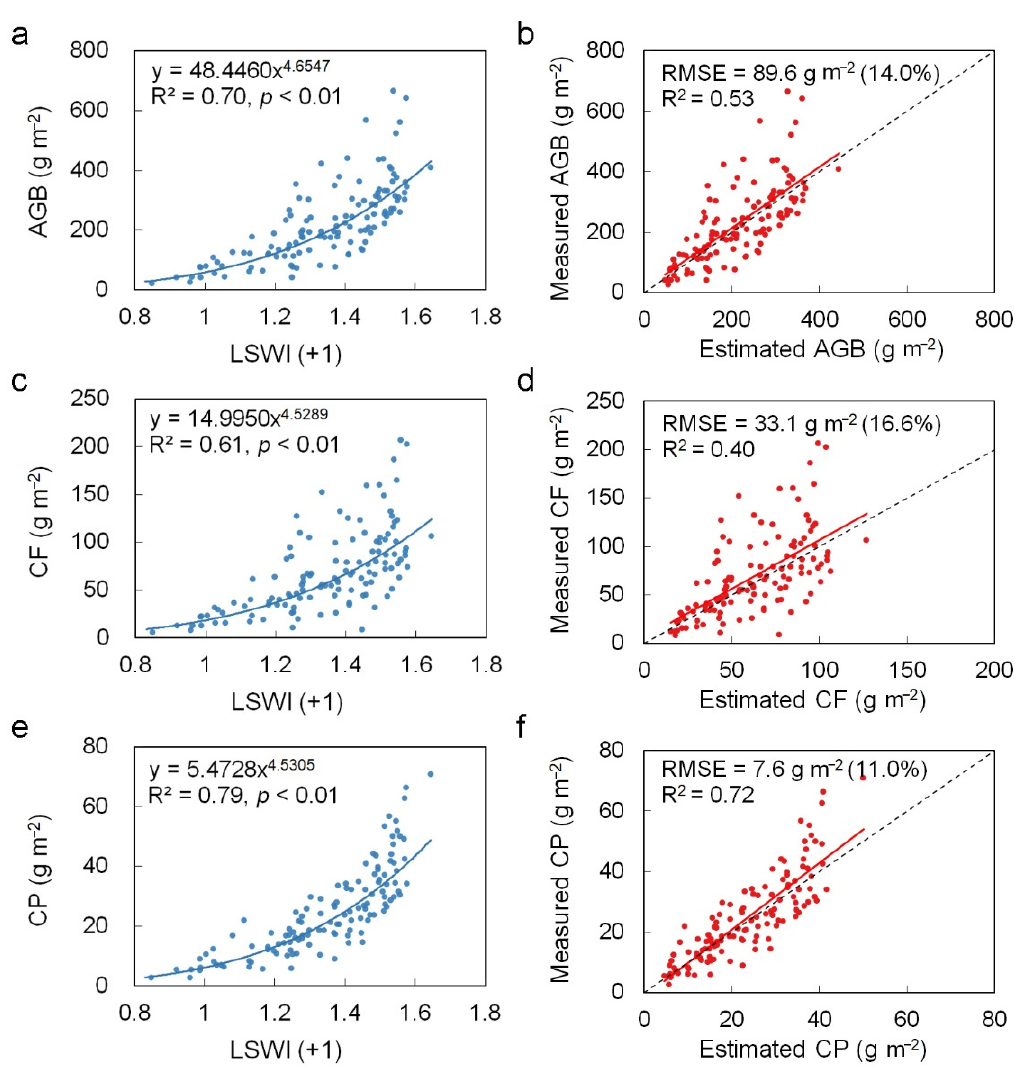
Figure 5. Power law models (using LSWI as the predictor) and prediction accuracies for forage biomass ( a , b ), crude fiber per area ( c , d ), and crude protein per area ( e , f ). Note that the independent variable of a power law function cannot be a negative value; we addressed this issue by adding a constant 1 to the LSWI (values ranging from − 1 to 1).